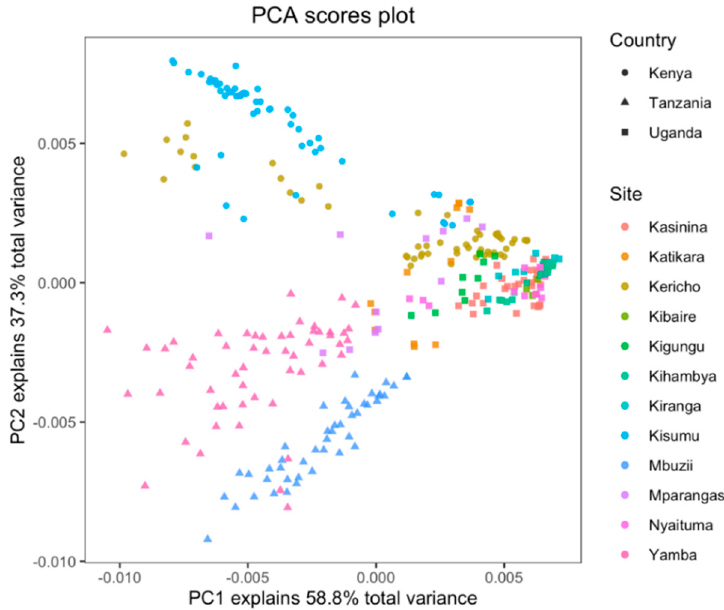
Figure 1. Biplot for the principal components explaining the largest variation.